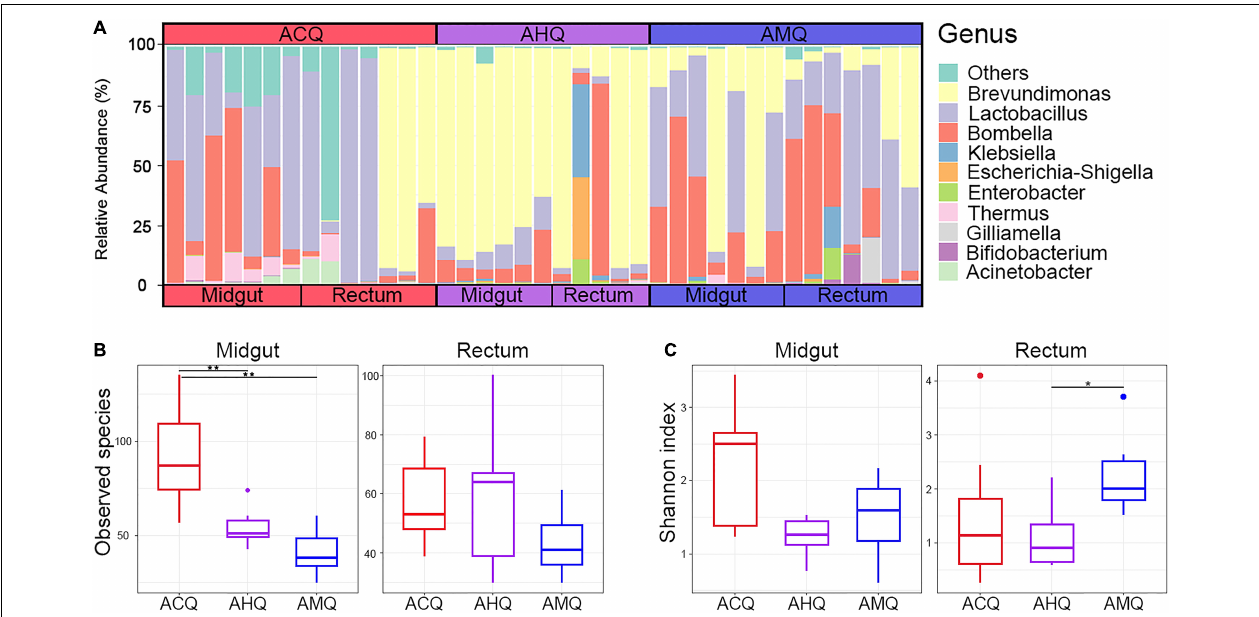
FIGURE 2 | Gut microbiota composition and α -diversity analysis of ACQs, AHQs, and AMQs. (A) Bacterial relative abundance of midgut and rectum at the genus level. (B,C) The results of observed species and Shannon indexes of α -diversity analysis shown by boxplots colored in red for ACQs, violet for AHQs, and blue for AMQs. * p < 0.05 and ** p < 0.01 represent the significance levels between groups calculated from the Kruskal–Wallis H